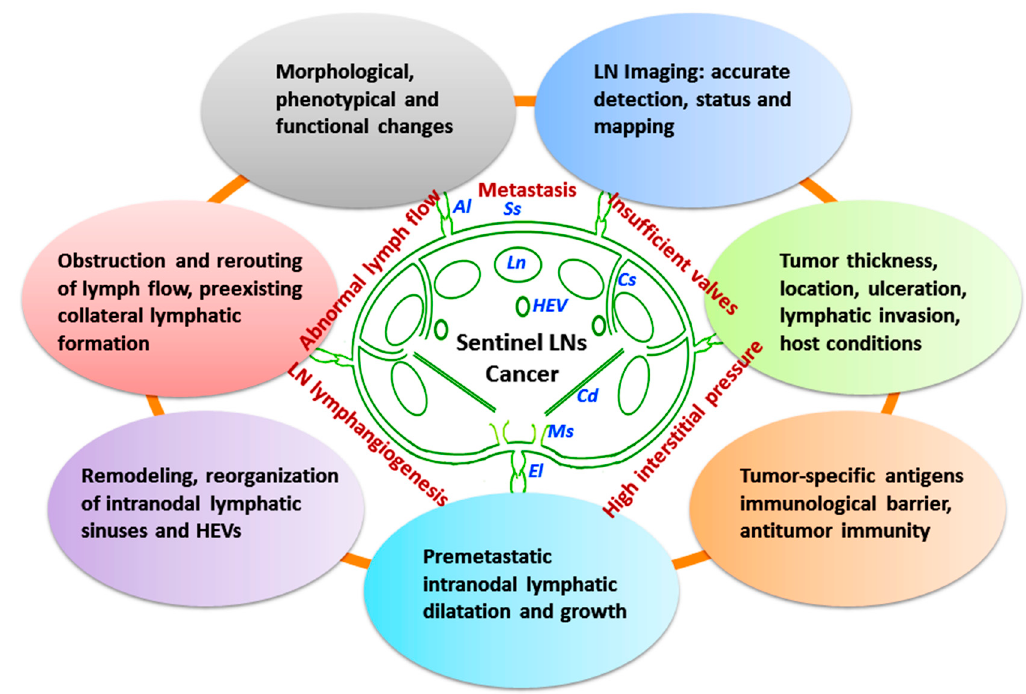
Figure 1. Lymph node (LN) remodeling and reconstruction. Sentinel LNs show obvious morphological and functional changes in tumor microenvironment. Al: afferent lymphatics; Ss: subcapsular sinuses; Cs: cortical sinuses; Ms: medullary sinuses; El: efferent lymphatics; Ln: lymph nodules; HEV: high endothelial venules; Cd: conduits.